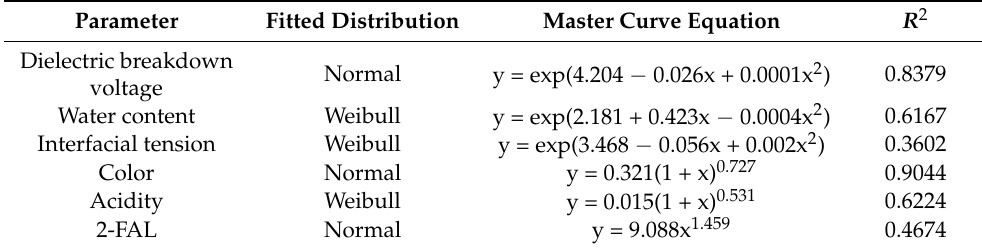
Table 4. The representative distribution for oil quality and furfural